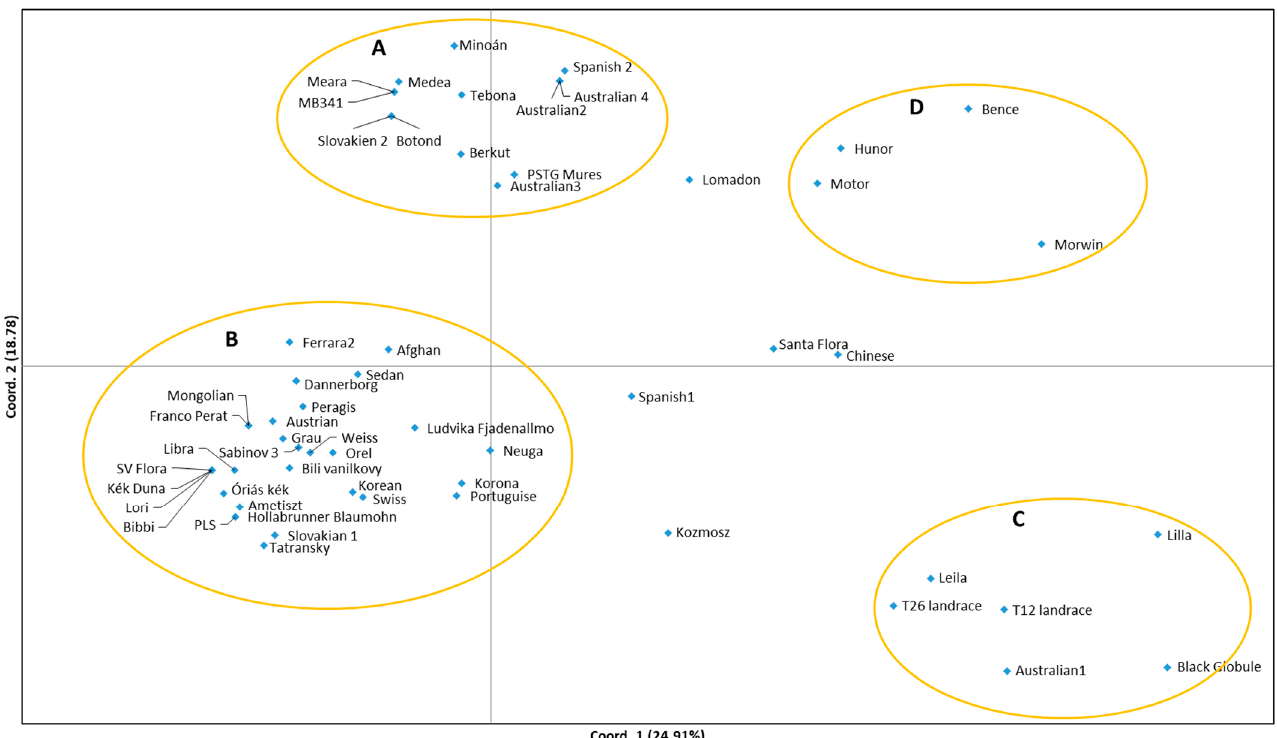
Figure 1. Two-dimensional plot of the principal coordinate analysis (PCoA) of SSR data showing the clustering of 58 opium poppy accessions. The 1st axis explains 24.91%, while the 2nd axis explains 18.78% of the variability.